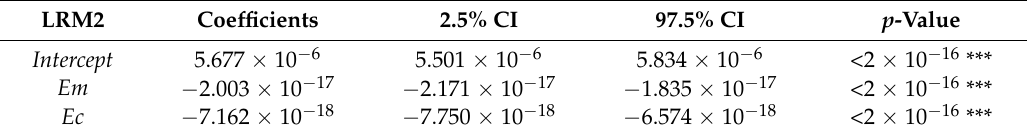
Table 6. Regression statistic for the second study: case 3.2.1—Thicker core.